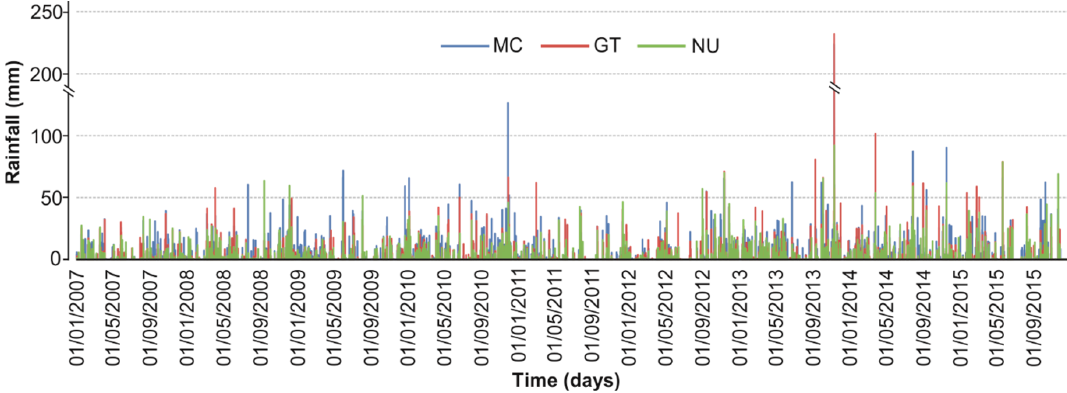
Figure 2. Daily rainfall data provided by of the Hydrographic Service of Umbria Region for three rain gauge stations: MC (Monte Cucco), GT (Gualdo Tadino), and NU (Nocera Umbra).